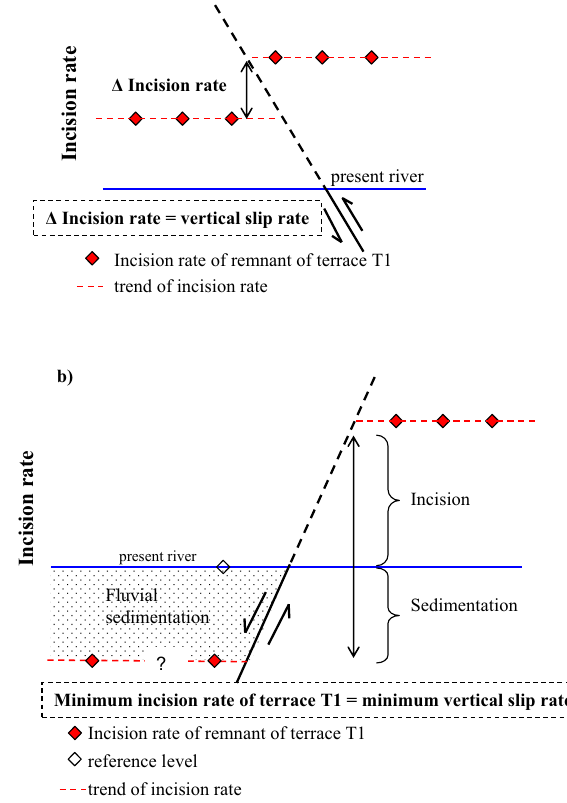
Figure 6. Definition of fluvial incision and vertical slip rate in a con- text of: (a) without sedimentation; (b) with sedimentation in the footwall block. In case b, the level of the present river is taken as a reference level in the footwall block. The incision and the vertical slip rates estimated are thus